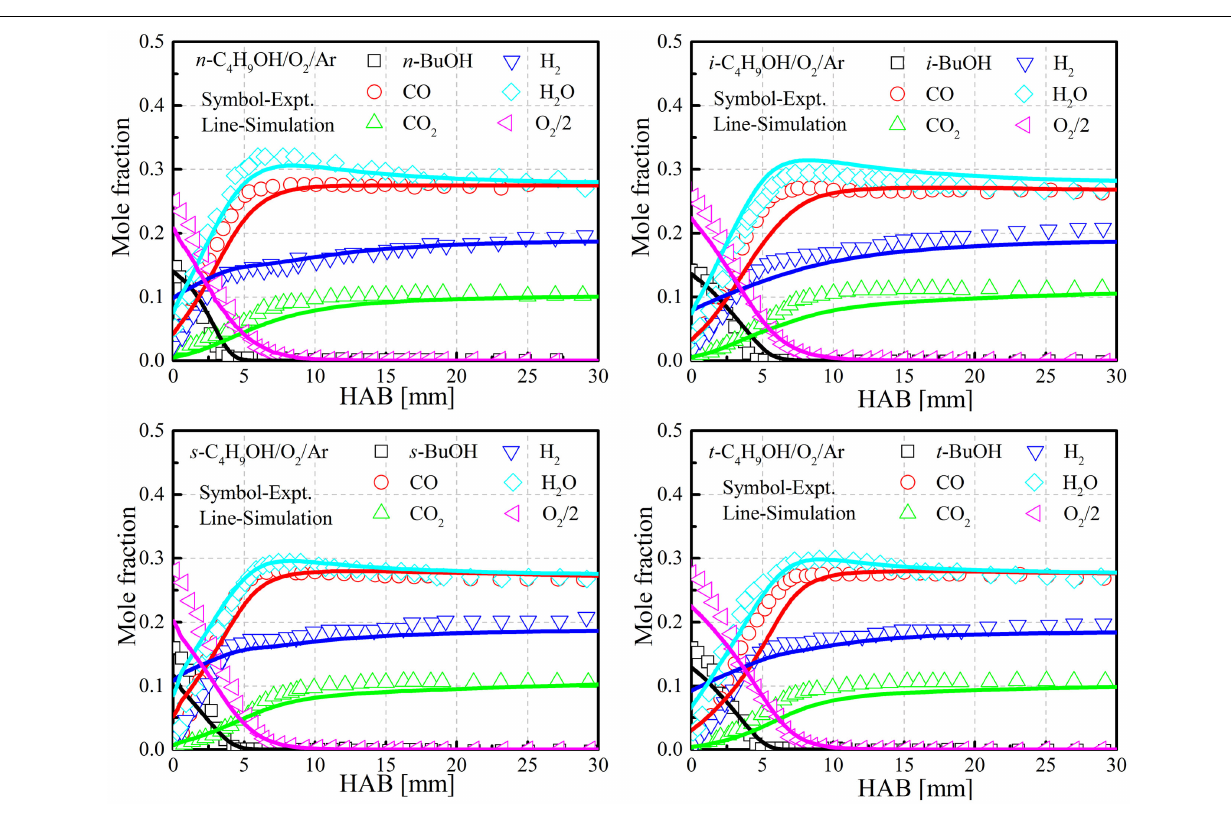
between n -butanol and iso -butanol under different